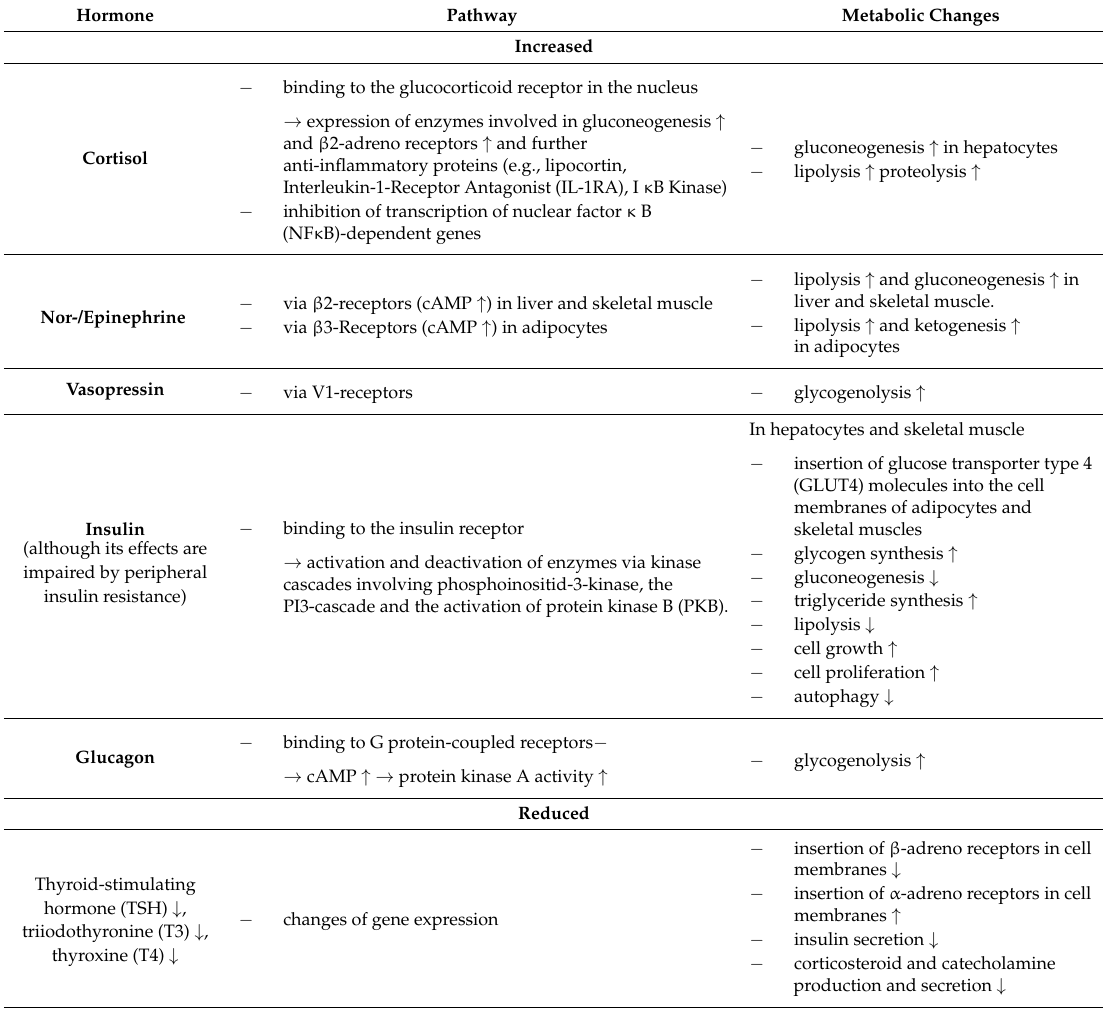
Table 1. Overview of the most dominant hormonal changes in systemic inflammation and their contribution to the observed metabolic changes. Upward arrows symbolize “upregualation”, downward arrows symbolize